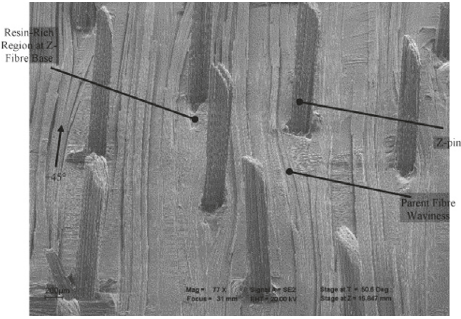
Figure 4: Z-pins reinforcements observed after pull-out